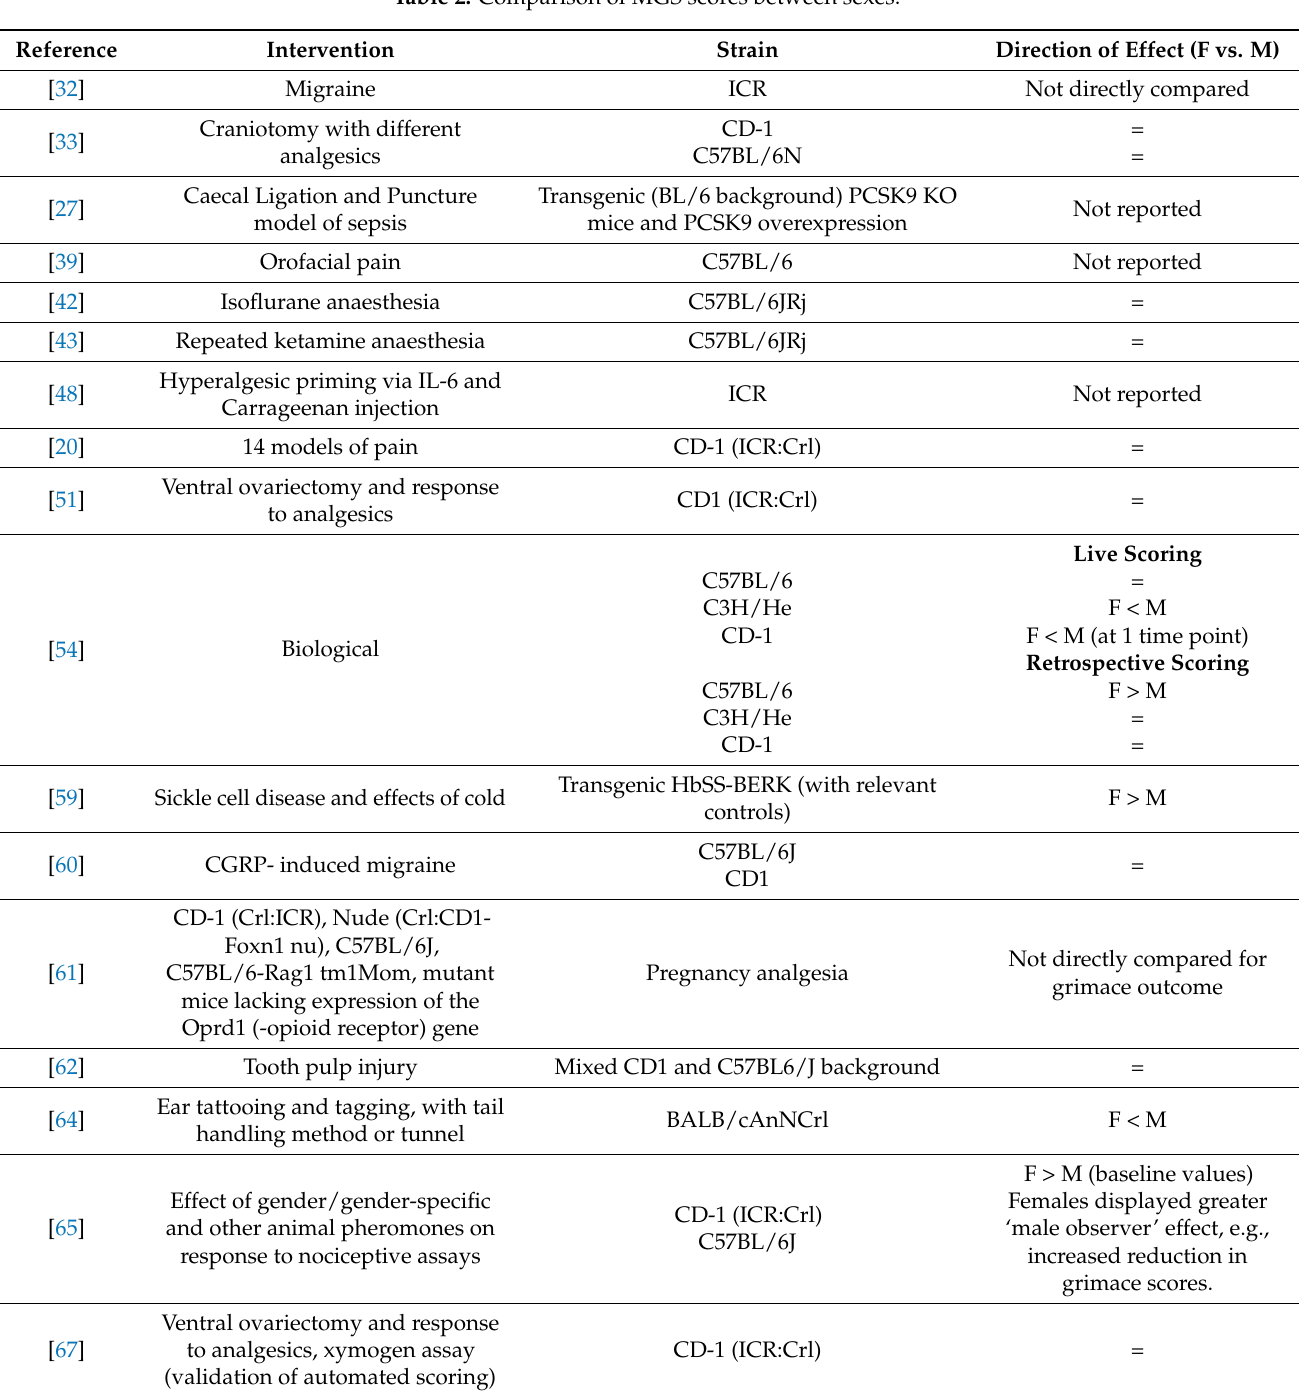
Table 2. Comparison of MGS scores between